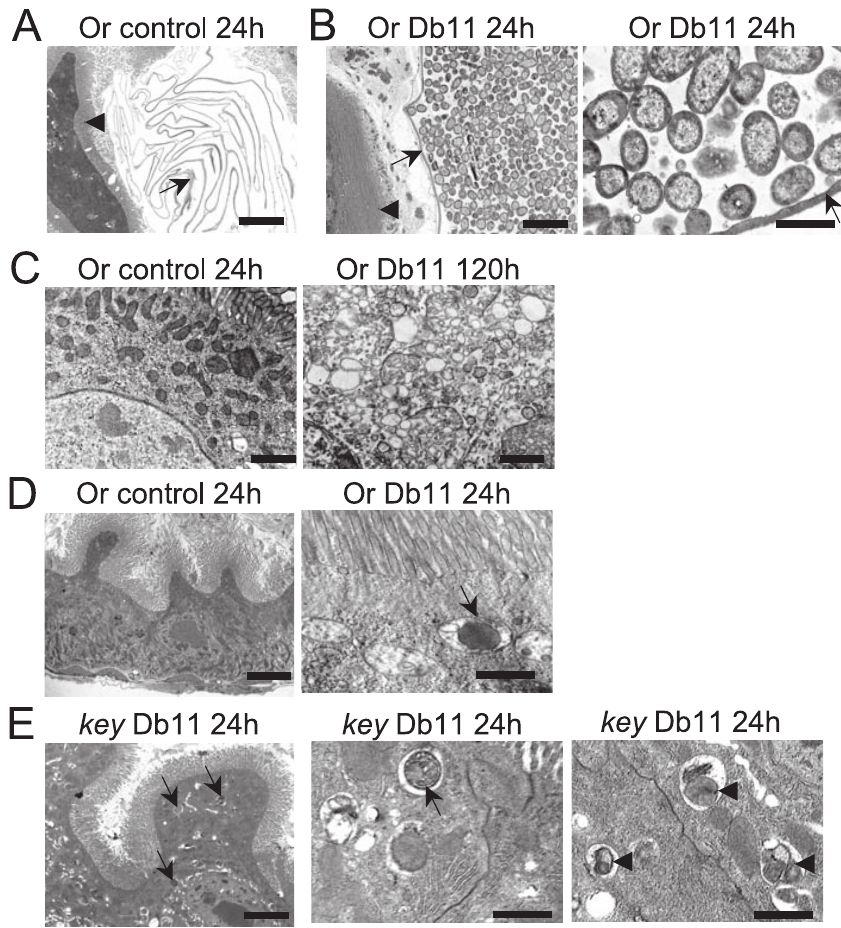
Figure 4. S. marcescens Is Found within Intracellular Vacuoles in the Midgut Epithelium Ultrastructure of wild-type and key mutant midguts fed on Db11 (OD ¼ 0.1) or sucrose. (A, B) The midgut epithelium with associated microvilli (arrowhead) is separated from the gut lumen by the peritrophic membrane (arrow). (A) Oregon fly fed for 24 h on sucrose. Note that the peritrophic membrane is sometimes folded extensively and that no microorganisms are present. (B) Oregon fly fed for 24 h on Db11. The bacteria are confined inside of the peritrophic membrane and are shown at high resolution in the right panel. Scale bars: (A, B) left panel: 5 l m; (B) right panel: 1 l m. (C) Oregon fly fed for 24 h on sucrose (left panel) or for 120 h on Db11 (right panel). The infected midgut epithelial cell displays translucent vacuoles evocative of cellular stress. (D) Oregon fly fed for 24 h on sucrose (left panel) or for 24 h on Db11 (right panel). An intracellular bacterium inside a vacuole is indicated by an arrow. (E) key mutant fly fed for 24 h on Db11. Intracellular bacteria are indicated by arrows and putative degraded bacteria by arrowheads. Scale bars are 5 l m for low magnification pictures ([A], [C], left panel in [B], [D], and [E]) and 1 l m in high magnification pictures (right panels in [B], [D], and